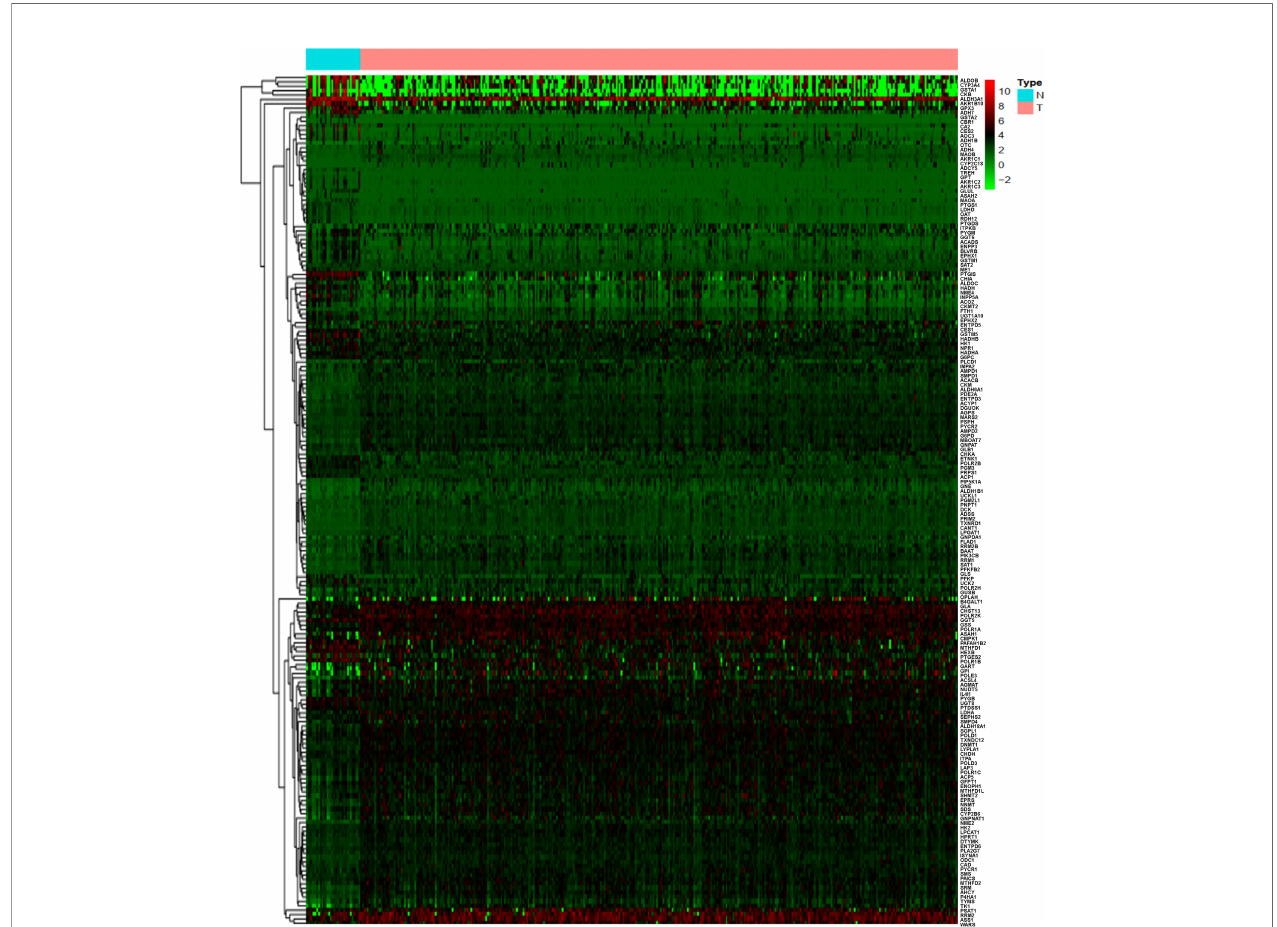
FIGURE 1 | Heatmap of the differentially expressed metabolism-related genes (DEMRGs) between normal and tumor issues in stomach adenocarcinoma [(STAD) (N, normal tissues; T, tumor